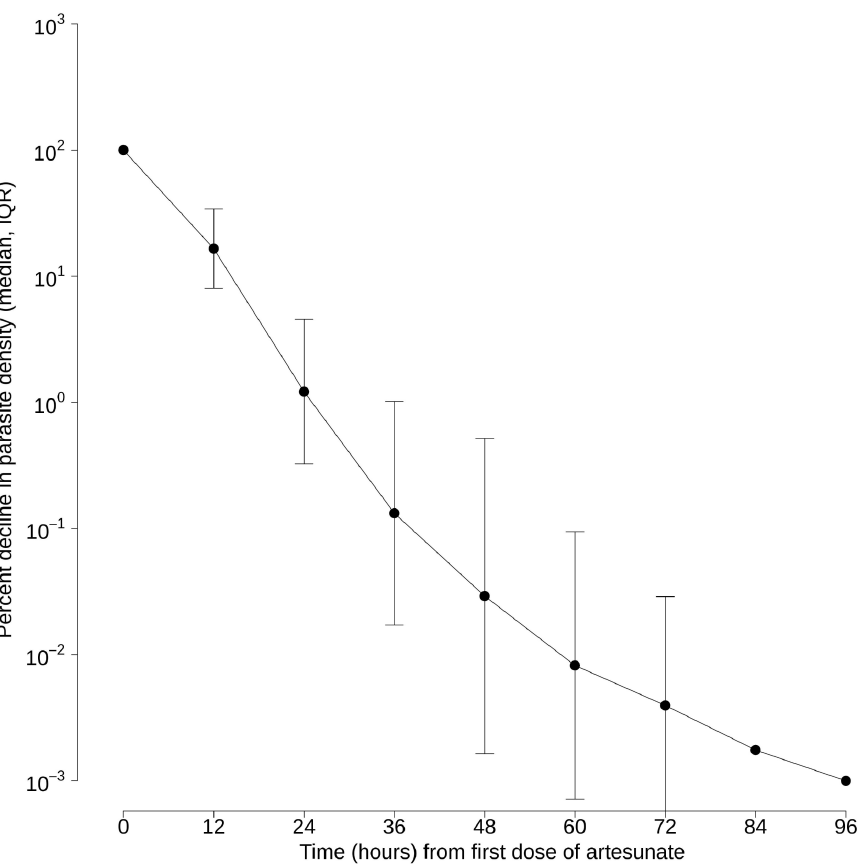
Figure 2. Parasite clearance curve showing linear regression of log 10 -normalized median parasite density over time.